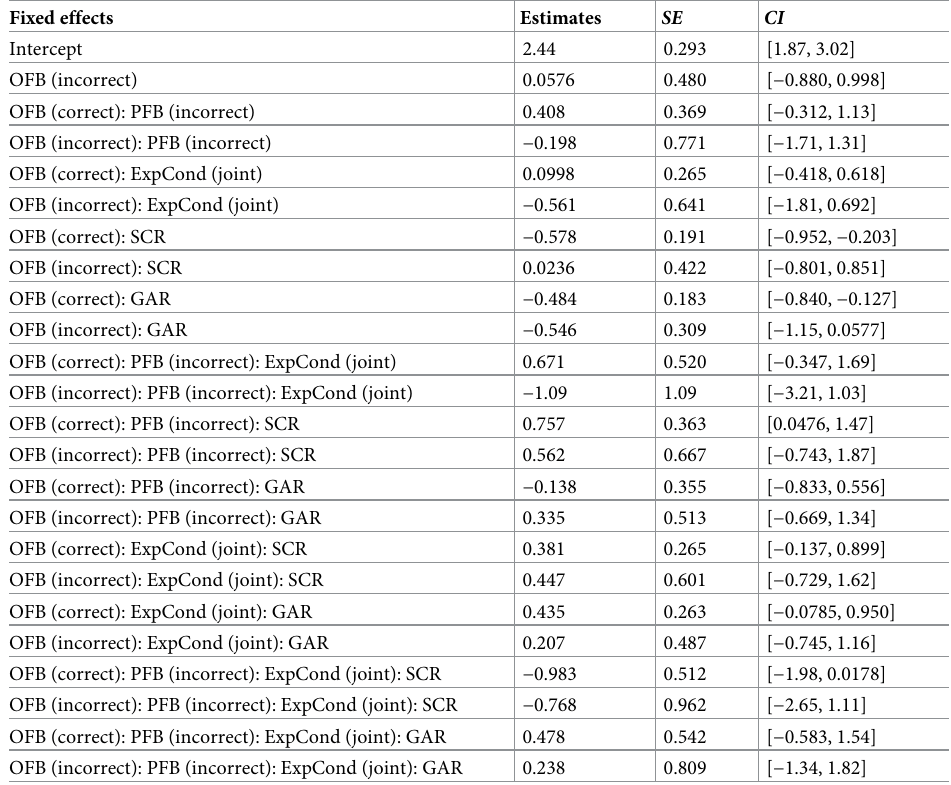
Table 2. Estimated coefficients of fixed effects in LME for FRN/RewP.